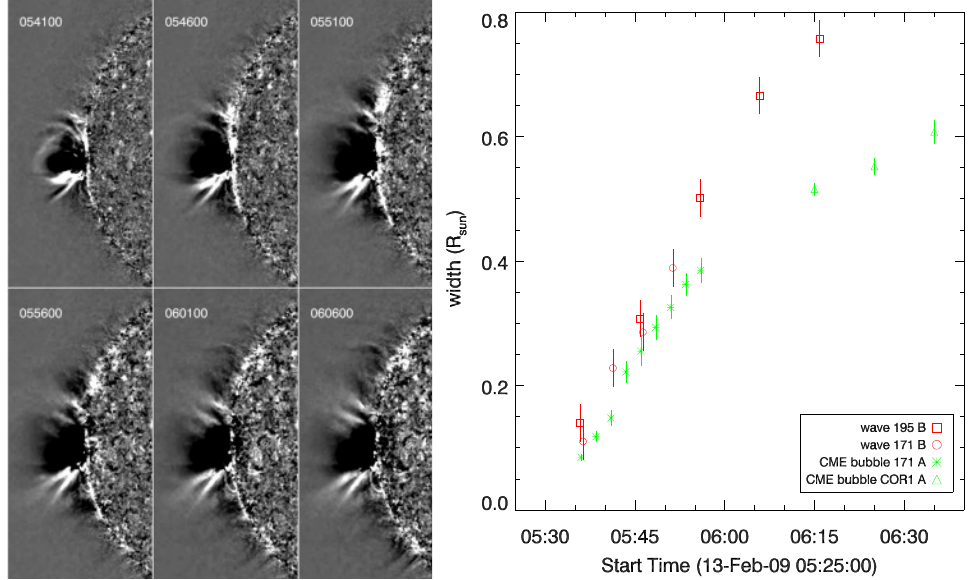
Figure 35: STEREO quadrature observations of the 2009 Feb 13 coronal wave. Left : EUVI 171 ˚A running difference images showing the propagation of the coronal wave in front of the expanding CME flanks. Right : Distance-time plot of the coronal wave ( red ) and the CME bubble ( green ). The wave is clearly ahead of the CME flanks and detaches completely when the flanks decelerate. Image reproduced with permission from Patsourakos and Vourlidas (2009), copyright by